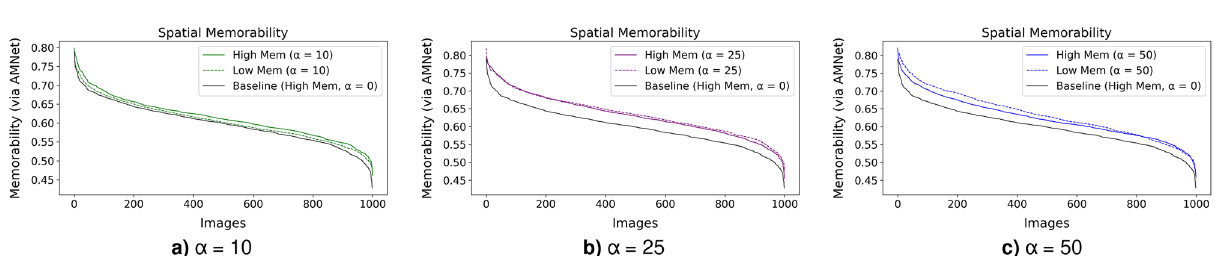
Figure 3. Predicted low and high memorability for different memorability weighting factors for α , considering α = 0 (in Eq. 3) as baseline. When increasing α , all generated images have a higher memorability than the baseline. The most memorable images overall are obtained with α = 25 , but the best pairwise effect is achieved with α = 10